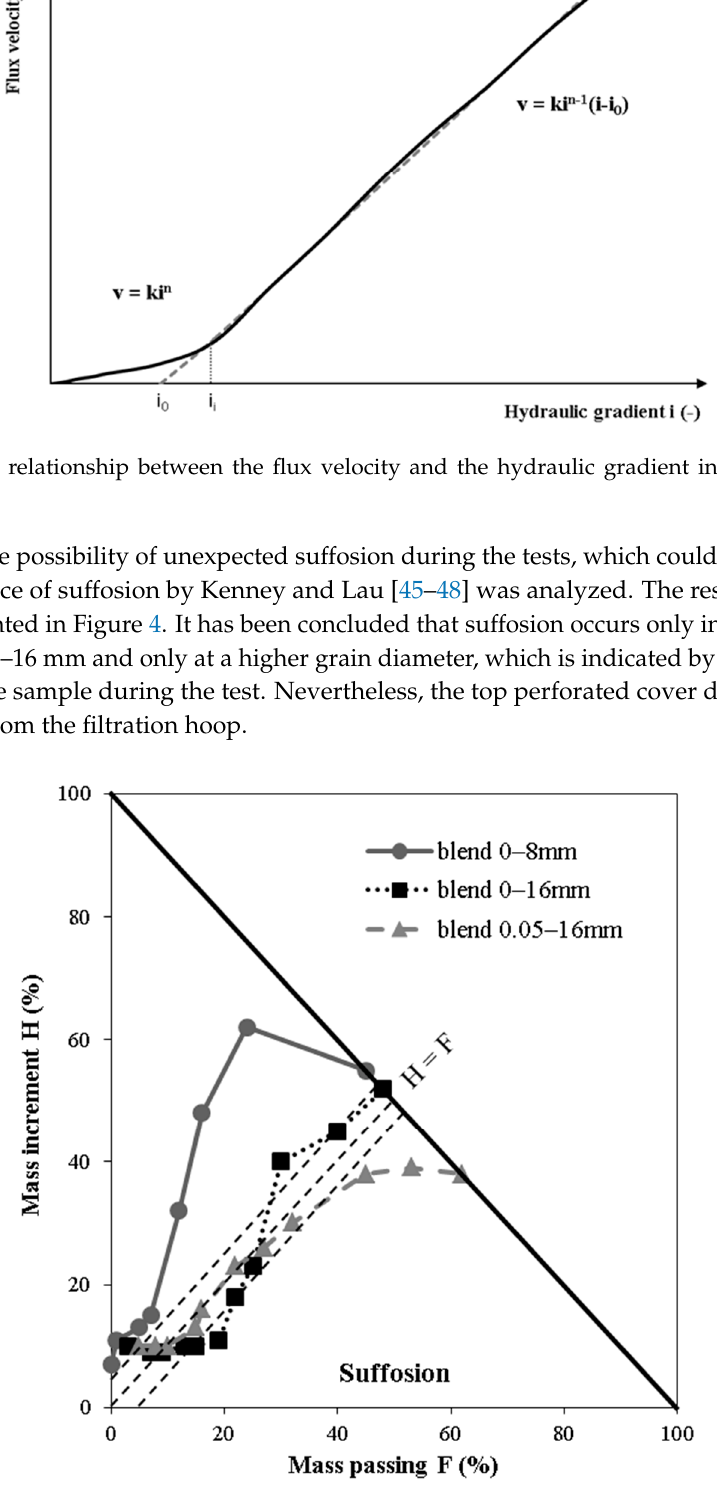
Figure 4. Results of suffosion analysis in respect to Kenney and Lau method [45] for the three blends of the RCA.